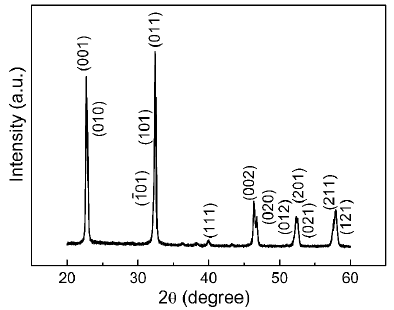
Figure 2. The X-ray diffractometer (XRD) pattern of the NaNbO 3 NFs after being annealed at 700 °C in oxygen.